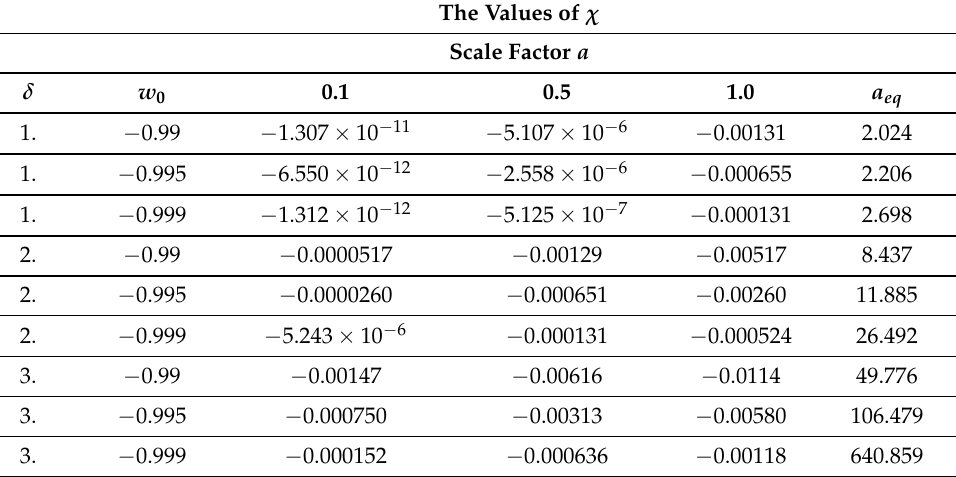
Table 2. The values of χ for all values of δ and w 0 for scale factors of 0.1, 0.5, and 1.0. The barely visible Figure 3 blue δ = 1 and w 0 = − 0.999 χ values are given by the last row of the δ = 1 χ values in the table. The equilibrium values of the scale factor a eq , discussed in Section 7.2, are in the last column. The Values of